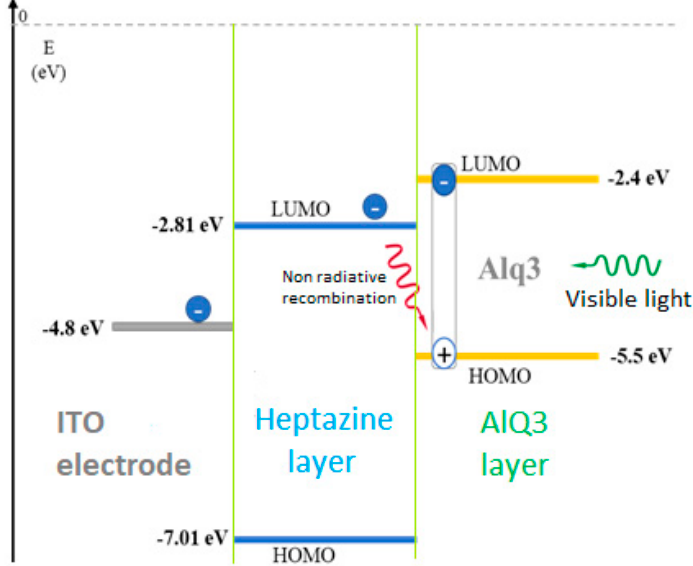
Figure 7. Scheme of the electron transfer from an activated Alq3 layer into an underlying sandwiched accepting heptazine 1 layer, deposited on an ITO electrode.